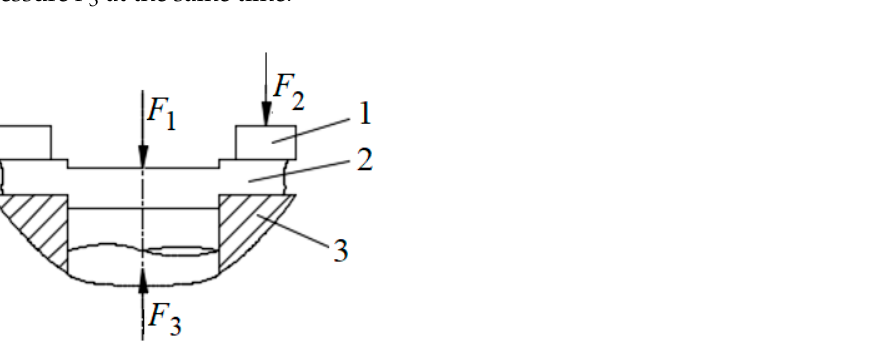
Figure 4. The stress during precision blanking. 1. Compaction block; 2. Workpiece; 3. Workbench.